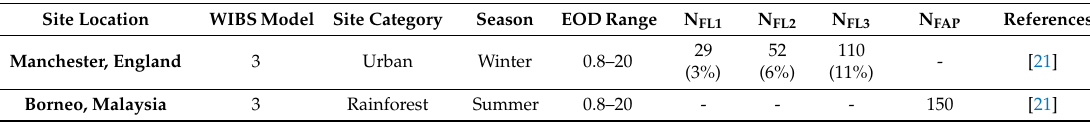
Table 4. Comparison between results of studies utilizing various models of the WIBS instrument. Equivalent Optical Diameter (EOD) is recorded in the µ m size range. Number-concentrations of fluorescent aerosol particles (FAP) is reported in L − 1 . (Numbers in parentheses are the fraction of fluorescent particles from the total particles collected as a